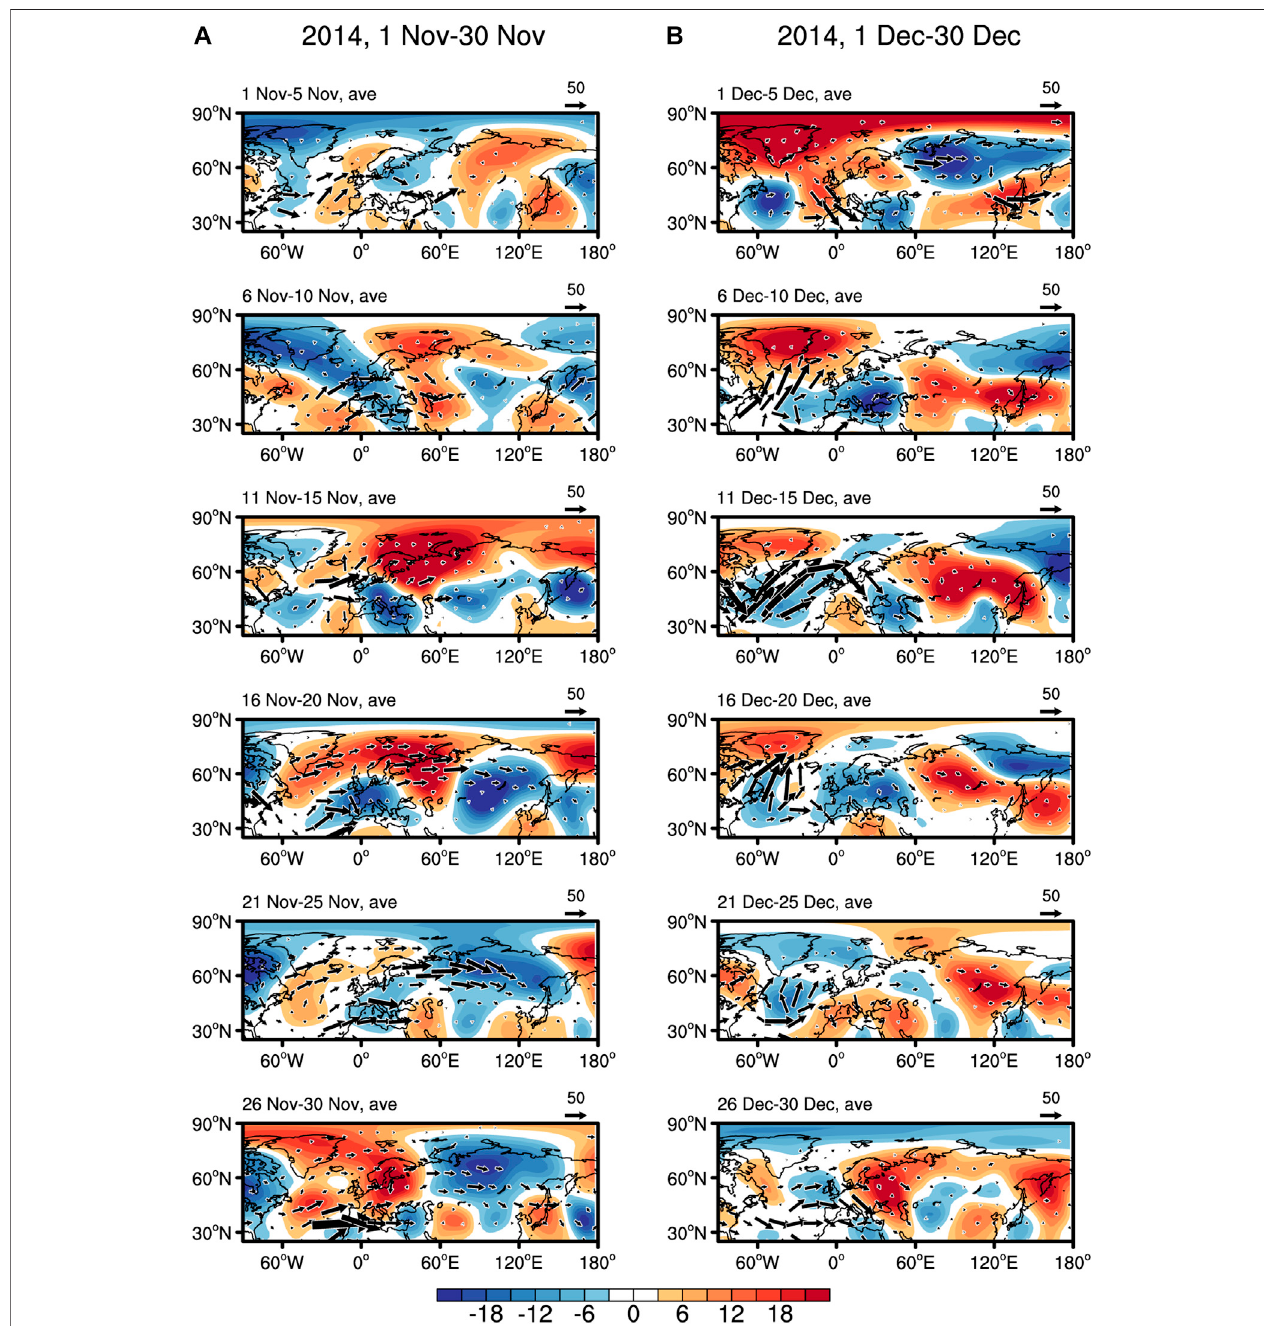
FIGURE 5 | As in Figure 4 but for the anomalies of horizontal WAF (arrows; unit: m 2 s − 2 ) and geopotential height (shading; unit: 10 m) at 500 hPa.